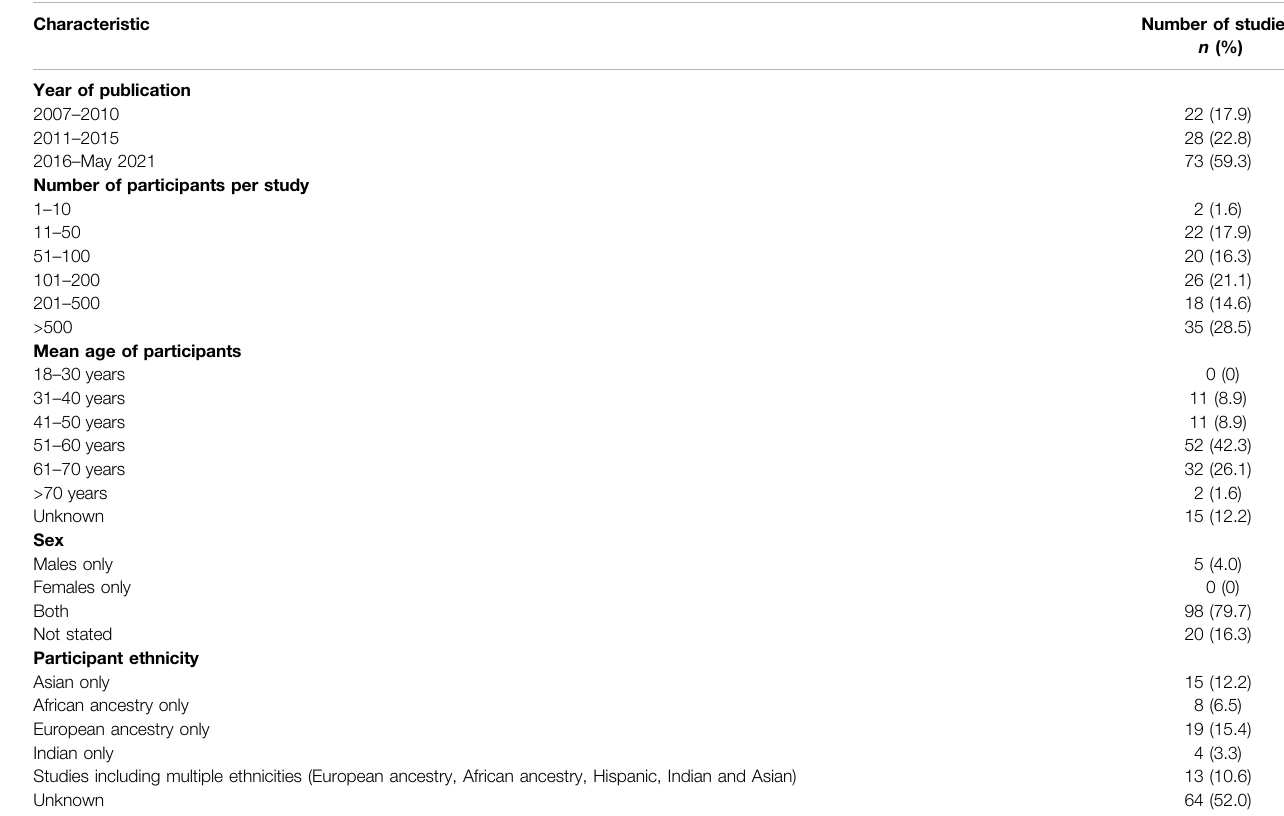
TABLE 2 | Participant and study characteristics reported in 123